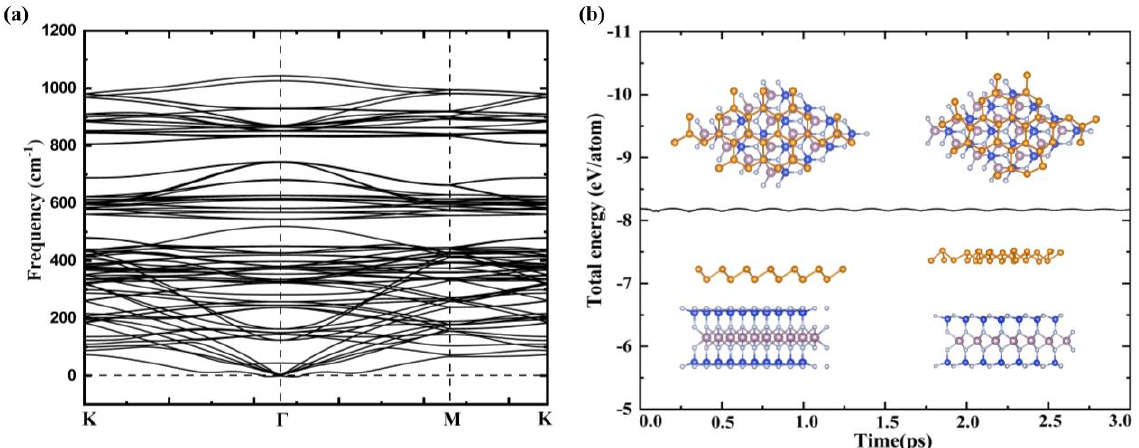
Figure 2. ( a ) Phonon spectra and ( b ) average total energy per atom vs time for the Blue P/MoSi 2 N 4 vdWH. The left and right insets in panel ( b ) are the initial and final structures, respectively, of Blue P/MoSi 2 N 4 vdWH during the AIMD simulations.